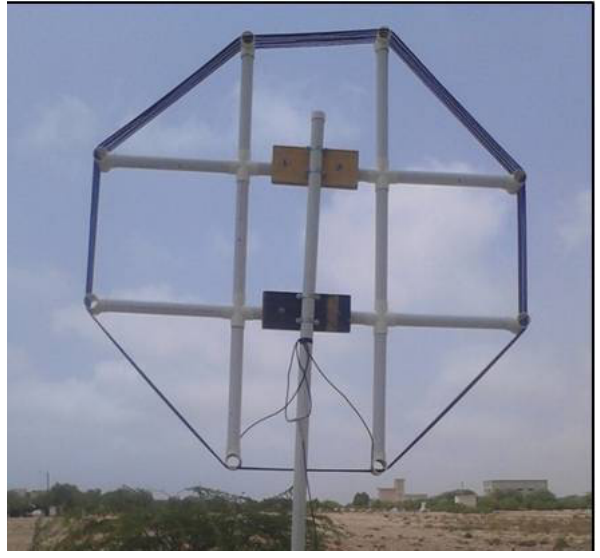
Figure 8. Antenna of the sudden ionospheric disturbance monitor installed at Sonmiani.